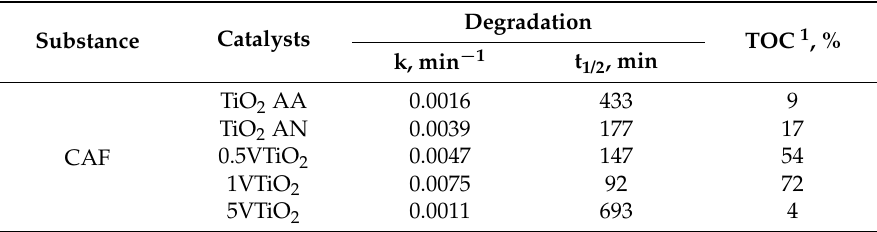
Table 2. Kinetic constant (k) and half-life time (t 1/2 ) values for degradation process with together TOC removal after 360 min of UV